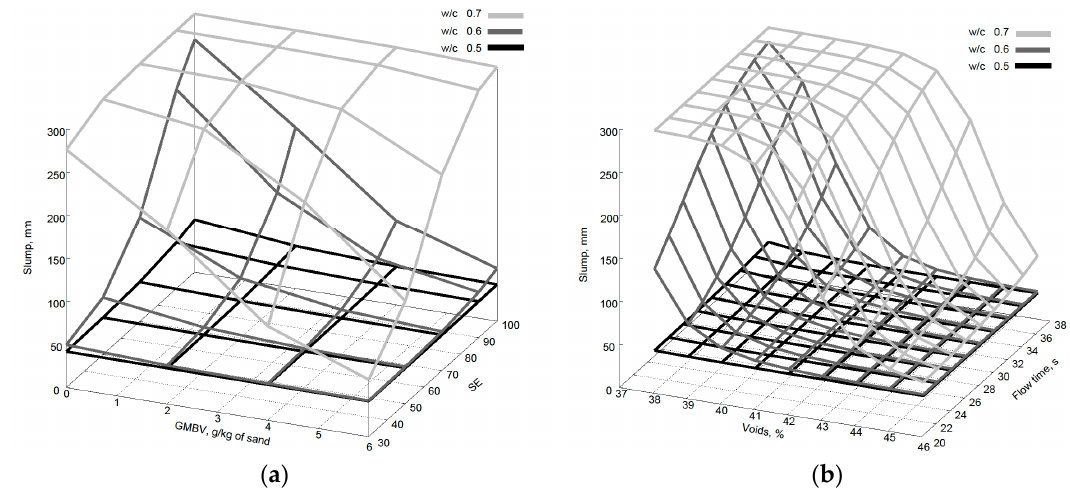
Figure 12. Variation of slump predictions with ( a ) change of SE and GMBV and ( b ) change in voids content and flow time.